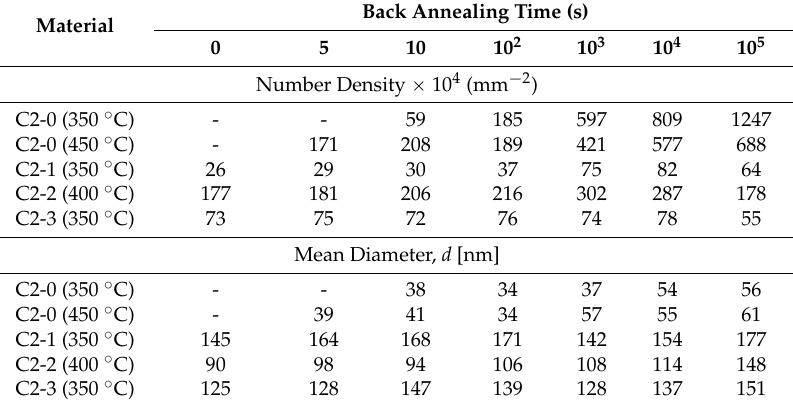
Table 6. Dispersoid number density and mean diameter as a function of annealing time measured for the different alloy conditions at selected annealing temperatures in the range 350 ˝ C to 450 ˝ C after cold rolling to strain of ε =